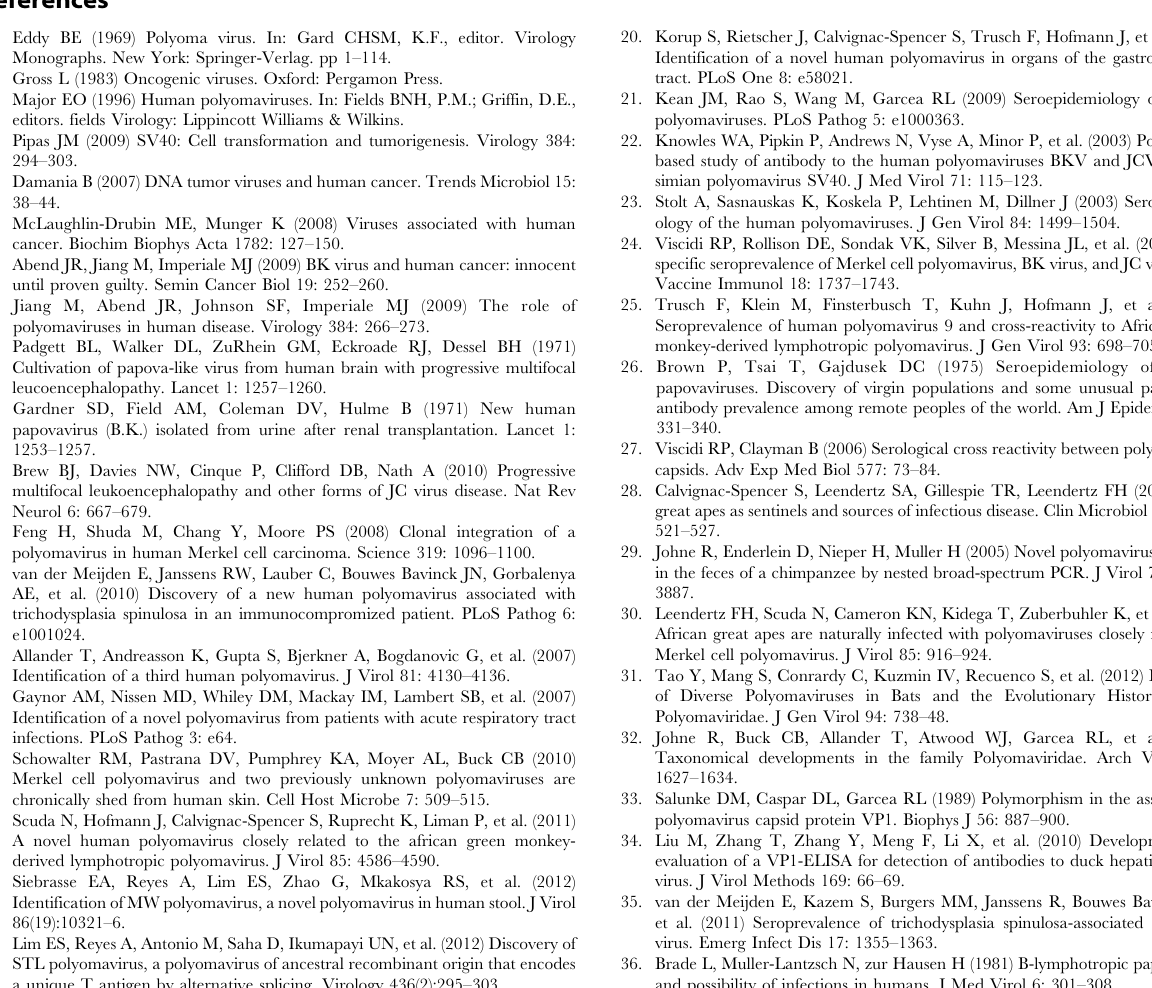
Table S4 Genomes and encoded proteins of the novel nonhuman primate polyomaviruses. (DOC) Table S5 Putative functional motifs in the large T- antigens of the novel NHP polyomaviruses. (DOCX) Table S6 Correlation of seroreactivities against VP1 antigens of polyomaviruses. (DOC) Text S1 LT-ag binding motifs in NCCR of novel NHP polyomaviruses. (DOCX) Text S2 Motifs in large T antigens of novel NHP polyomaviruse.